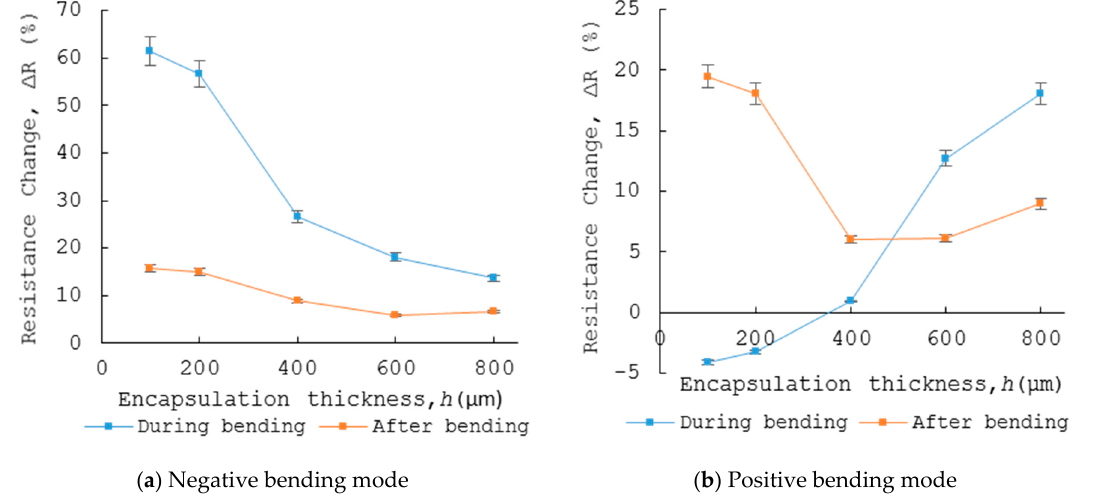
Figure 5. Resistance changes for gauges on Escalade fabric along weft weave (or elastic) direction. Table 2. Resistance change in strain gauges at different encapsulation thickness, h .